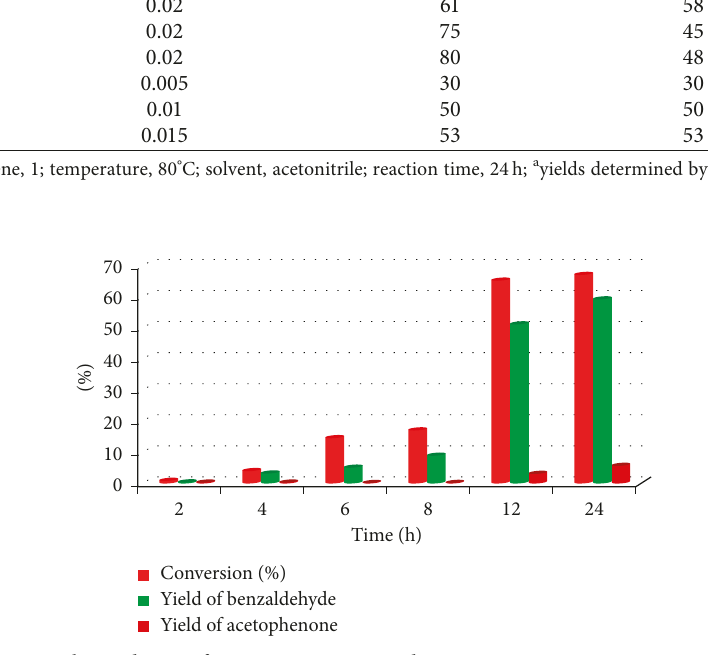
° C; solvent, acetonitrile. 2 O 2 /styrene, 1; temperature, 80